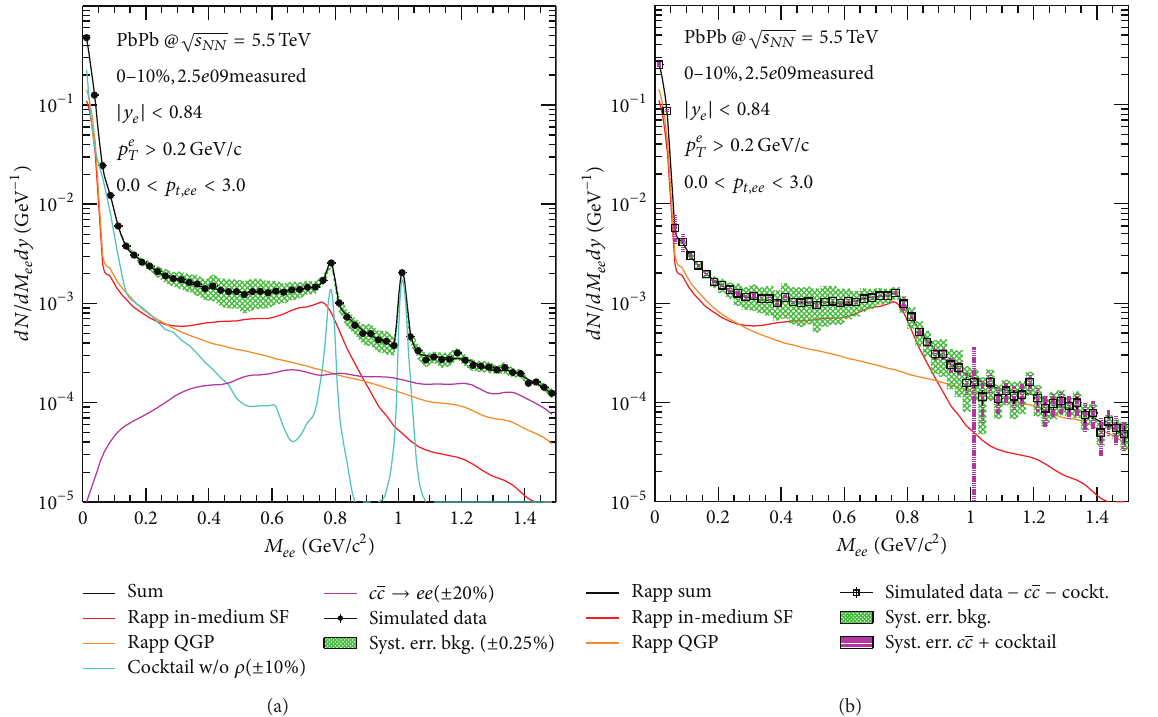
Figure 11: Simulations of dielectron invariant-mass spectra in Pb-Pb(5.5ATeV) collisions assuming the thermal spectra shown in (a) of Figure 10 as the excess signal [83, 84]. In addition to the acceptance cuts on single-electron rapidity and momentum, pair efficiency and displaced vertex cuts are included here. (a) Invariant-mass spectra after subtraction of combinatorial background; in addition to the thermal signal, the simulated data contain the hadronic cocktail and correlated open-charm decays. (b) Simulated excess spectra after subtraction of the cocktail and the open-charm contribution using displaced vertex cuts.